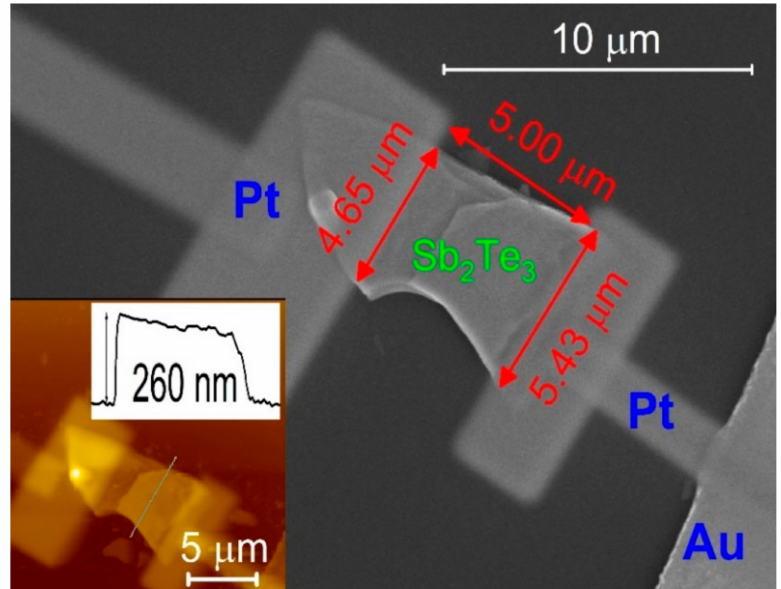
Figure 2. The SEM picture of the Sb 2 Te 3 flake for the photocurrent experiment. Two Pt contacts were deposited on the Sb 2 Te 3 flake. The left-bottom inset shows an Atomic Force Microscope (AFM) picture of the Sb 2 Te 3 flake and the AFM thickness profile of the flake. The thickness is about 260 nm.